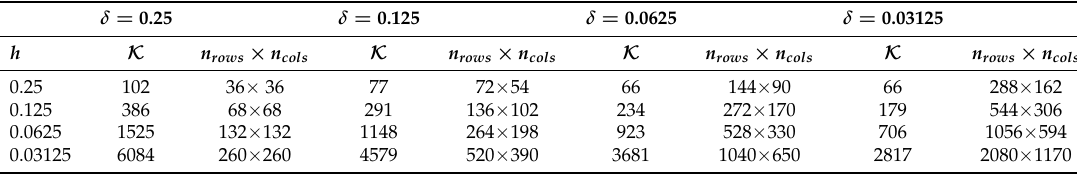
Table 2. The condition number K (rounded to the nearest integer) and the dimensions n rows × n cols of the discretization matrix ( Q ⊗ A + L ⊗ B ) for α = 0.5 as a function of the space step h and the time step δ